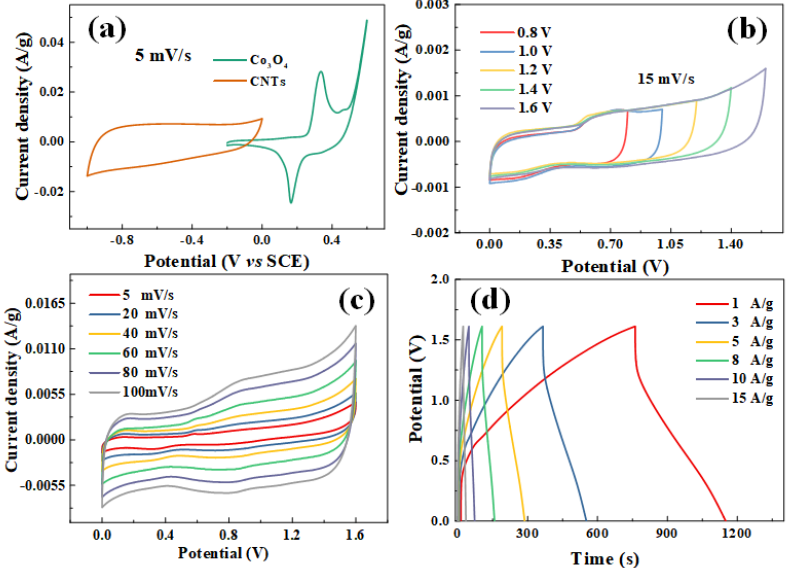
Figure 7. ( a ) CV curves of the hybrid Co 3 O 4 electrode and CNTs electrodes in a three − electrode cell in a 2 M KOH electrolyte at a scan rate of 5 mV/s. ( b ) CV curves of the optimized Co 3 O 4 //CNTs device collected at different potential windows at a scan rate of 15 mV/s. ( c ) CV curves of Co 3 O 4 //CNTs devices at scanning speeds of 5, 20, 40, 60, 80, and 100 mV/s. ( d ) Charge and discharge tests of Co 3 O 4 //CNTs devices for varied current densities.